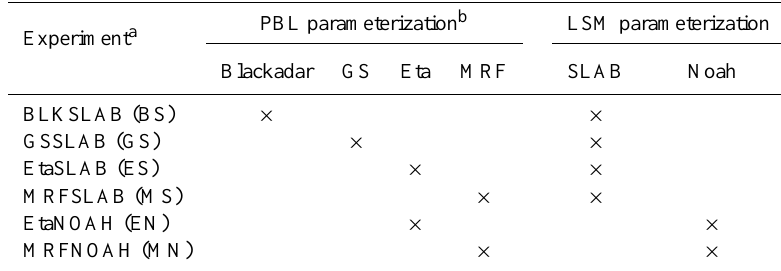
Table 1. Summary of numerical